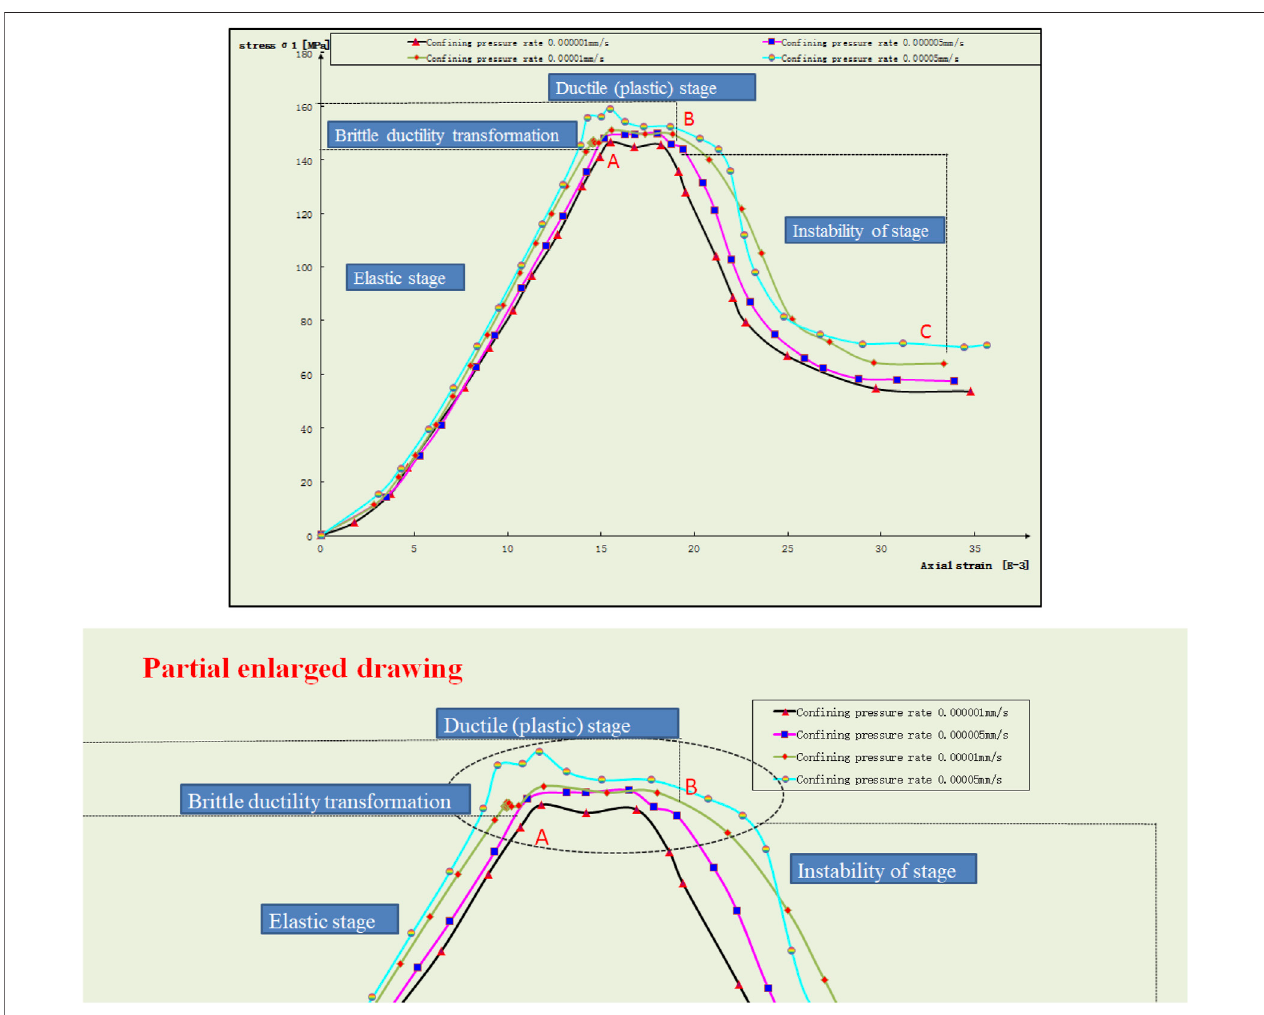
FIGURE 12 | Stress – strain curves of rock under four kinds of con fi ning pressures and partial enlarged.